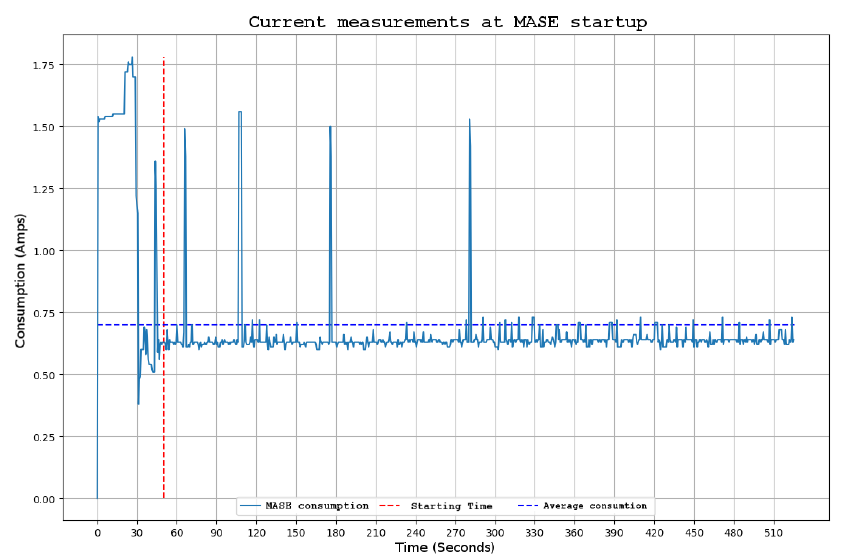
Figure 7. MASE consumption during start-up and